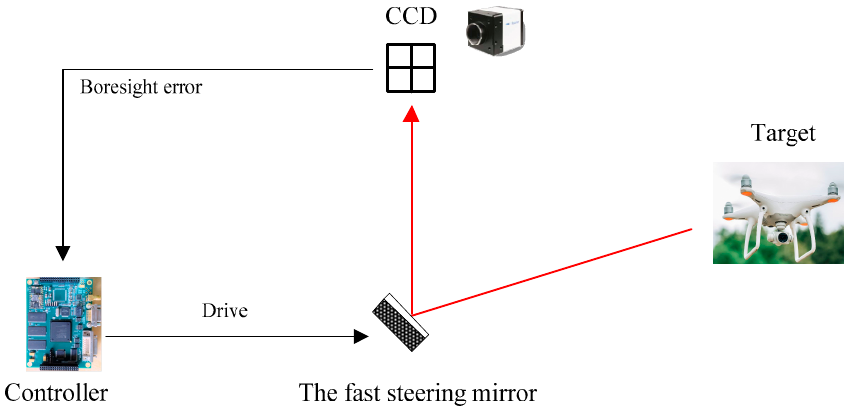
Figure 1. Configuration of the MOTS.